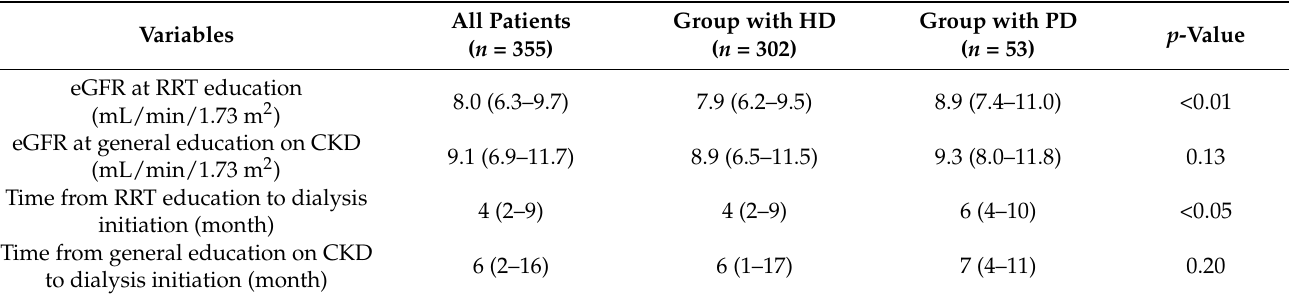
Table 3. Timing of education and choice of dialysis